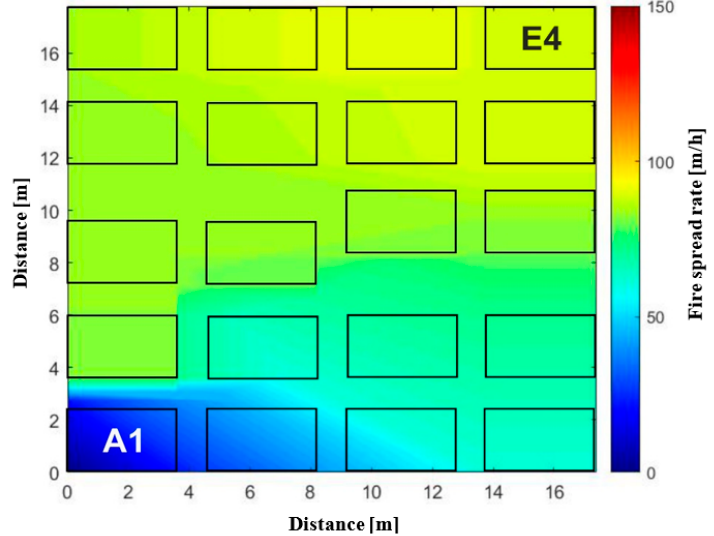
Figure 13. Colour map depicting the fire line progression rate relative to time zero, and the pattern of the baseline simulation, where only dwelling A1 is ignited.